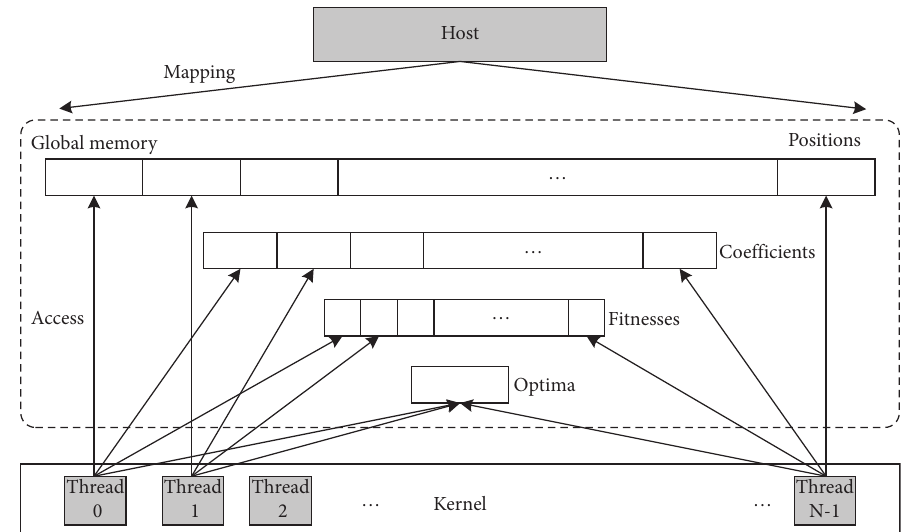
Figure 4: Dataflow of PWOA-PPM between host and